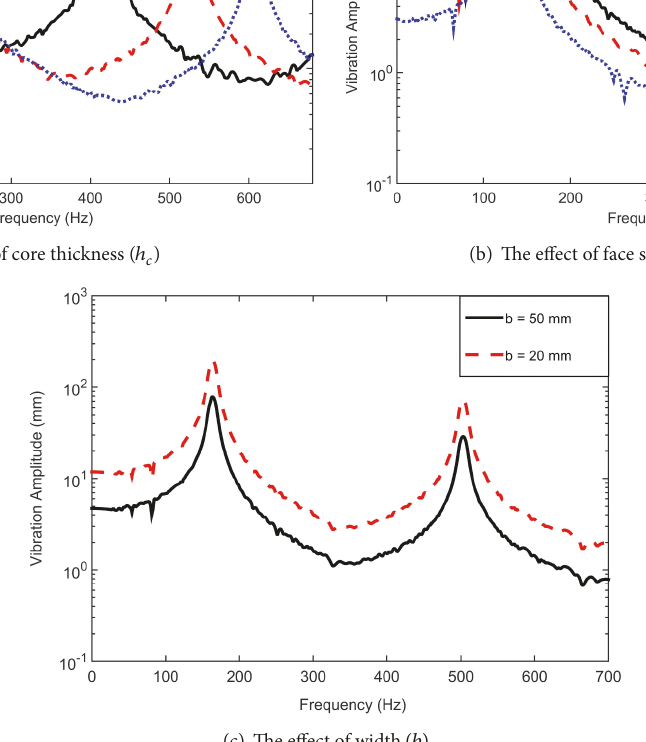
Figure 5: Vibration amplitude at the tip of the cantilever beam with respect to applied